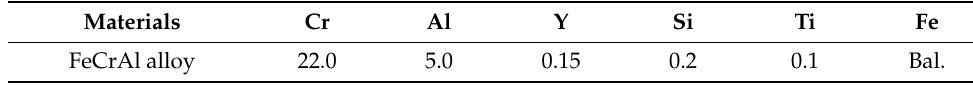
Figure 1. ( a ) Schematic diagrams of powder can (in mm) and ( b ) schematic diagrams of thermo-mechanical treatment process. Table 1. Chemical composition of the FeCrAlY alloy